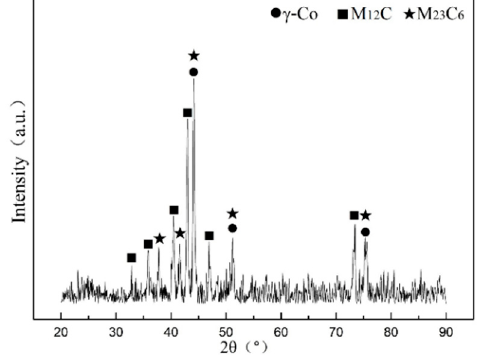
Figure 3. SEM back-scattered electron image of the obtained bulk cobalt-based alloy.